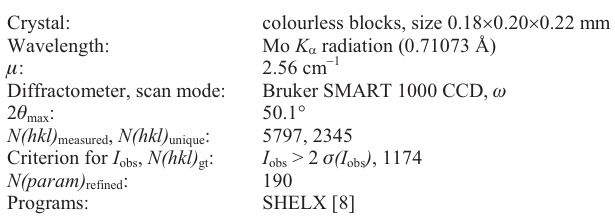
Table 1. Data collection and handling.